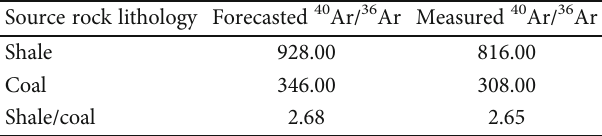
Figure 12: Crossplots of 40 Ar/ 36 Ar versus 38 Ar/ 36 Ar of gases within the Longtan tight sandstones, shales, and coals in west Guizhou, showing that 40 Ar/ 36 Ar values of the Longtan shale and tight sand gas are close in value, 40 Ar/ 36 Ar values of the Longtan coal and tight sand gas di ff er signi fi cantly in value, and the 38 Ar/ 36 Ar values of the Longtan shale, coal, and tight sand gas are very close in value. Table 6: Forecasted and measured 40 Ar/ 36 Ar ratios of shales and coal seams in the Longtan Formation in west